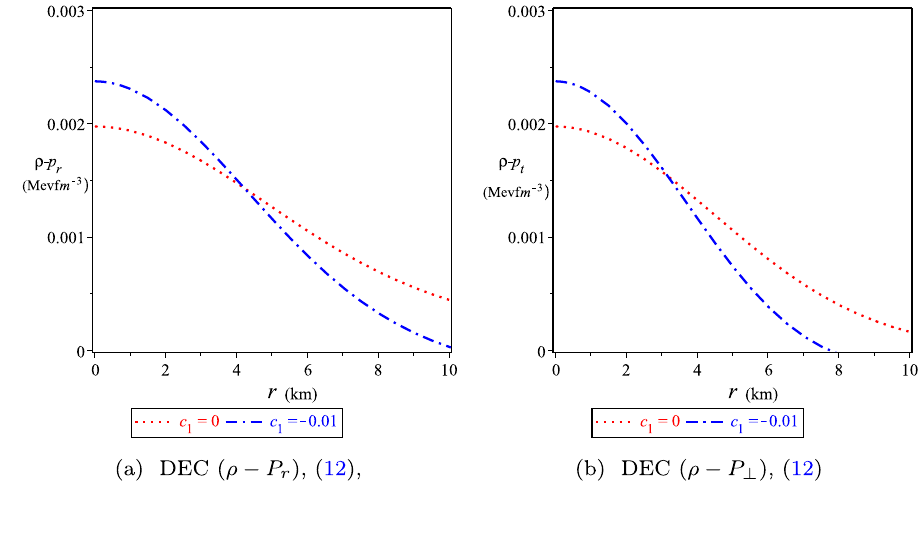
Fig. 6 Radial, transverse speed of sound, and v ⊥ 2 − v r 2 . The plots of radial and transverse speeds indicate that our model satisfies the causality condition Fig. 7 DEC of solution